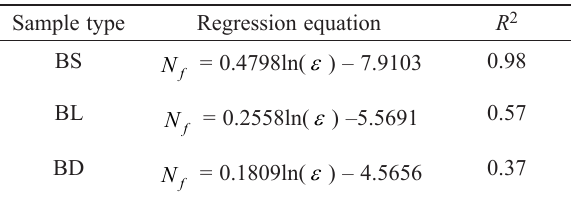
Table 6. Correlation equations relating fatigue behavior of binders and HMA mixes Sample